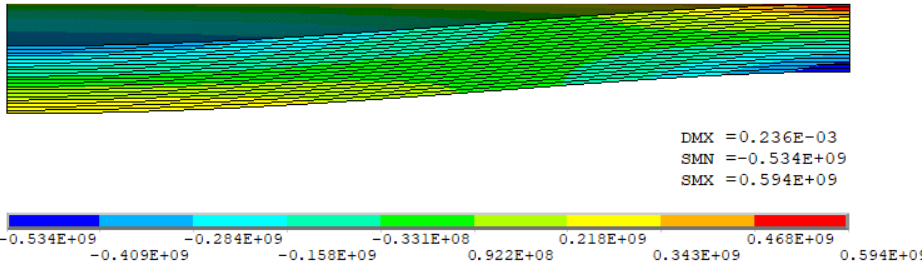
Figure 17. Radial stress field on the contour, multilayered plate, multilayered FE. in the clamped edges is presented. The variation is approximately linear, as it is known from general plate theory. As can be seen in Figure 18, in the middle of the plate, the stress is not zero, so the neutral plane is not positioned at the half of plate thickness. Addition- ally, the extreme stress values are not equal.